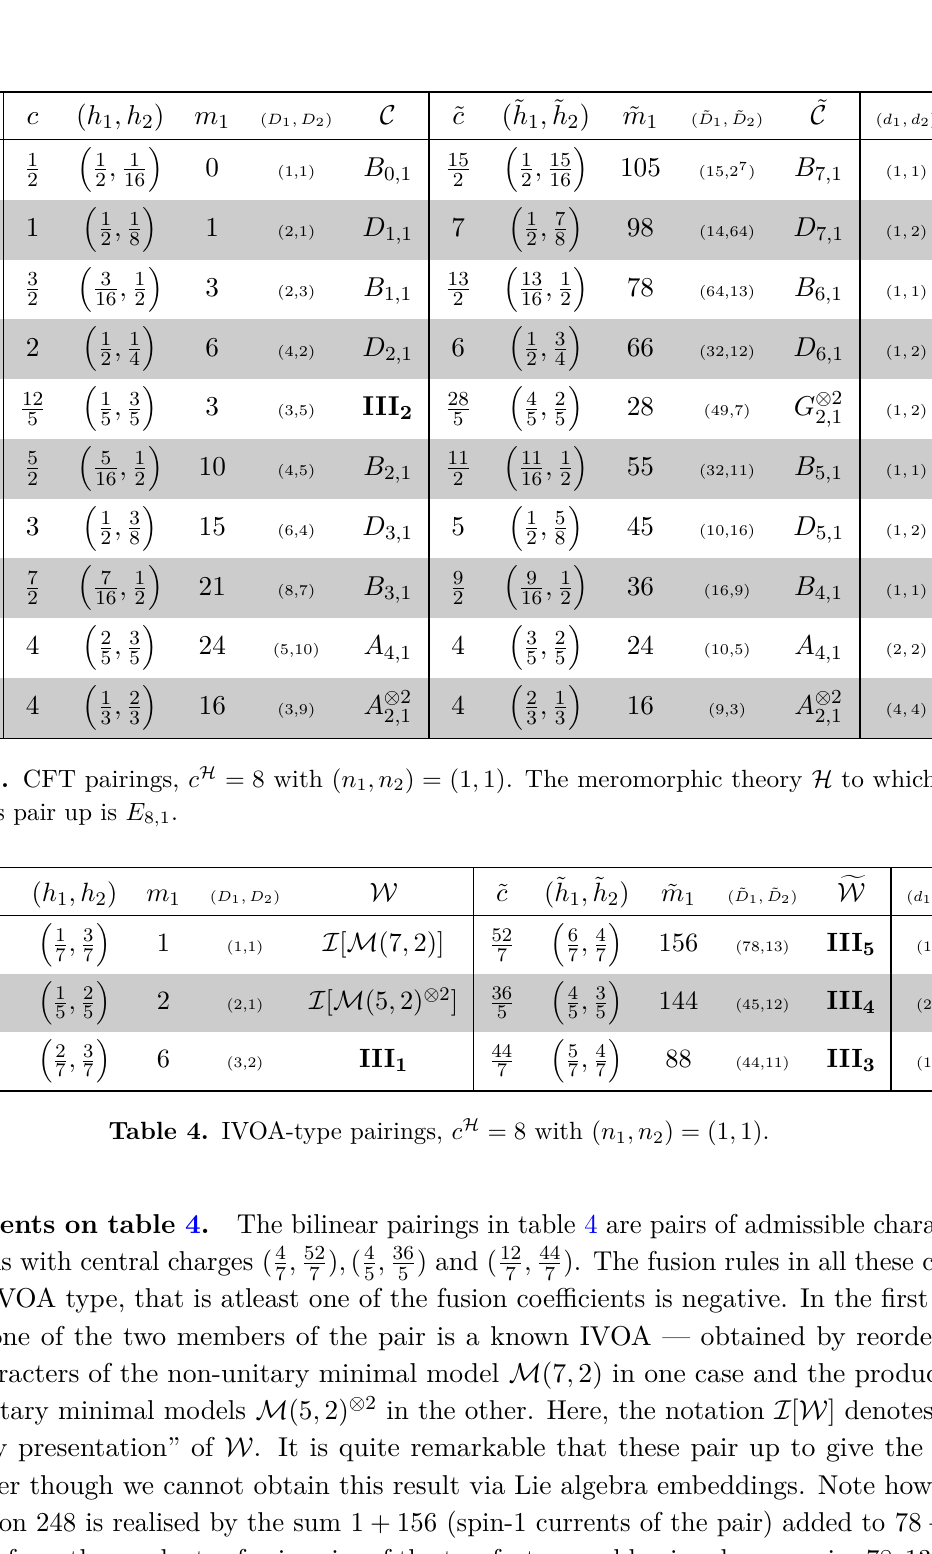
Comments on table